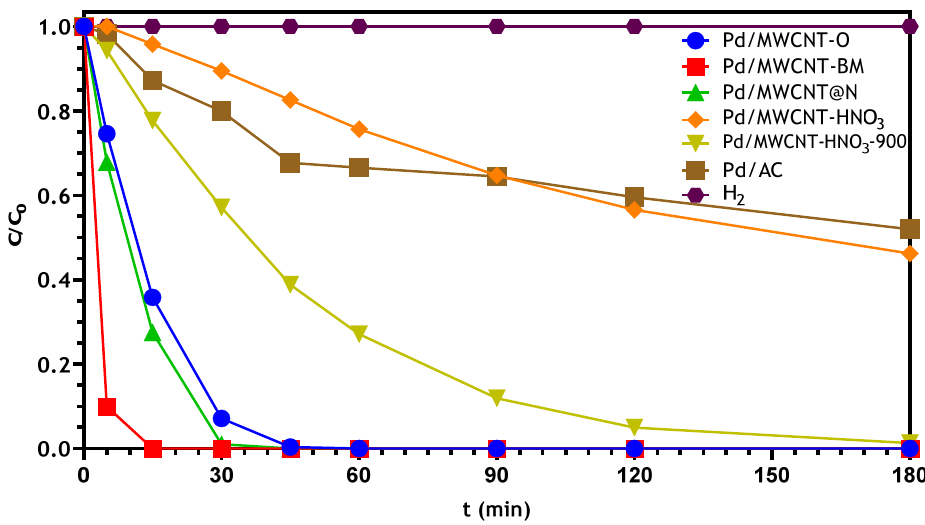
Figure 2. Dimensionless bromate concentration during semi-batch hydrogen reduction over 1 wt.% Pd catalysts on different carbon supports. (H 2 = 50 cm 3 min − 1 , C 0 (BrO 3 − ) = 200 ppb, 0.125 g CAT L − 1 ).